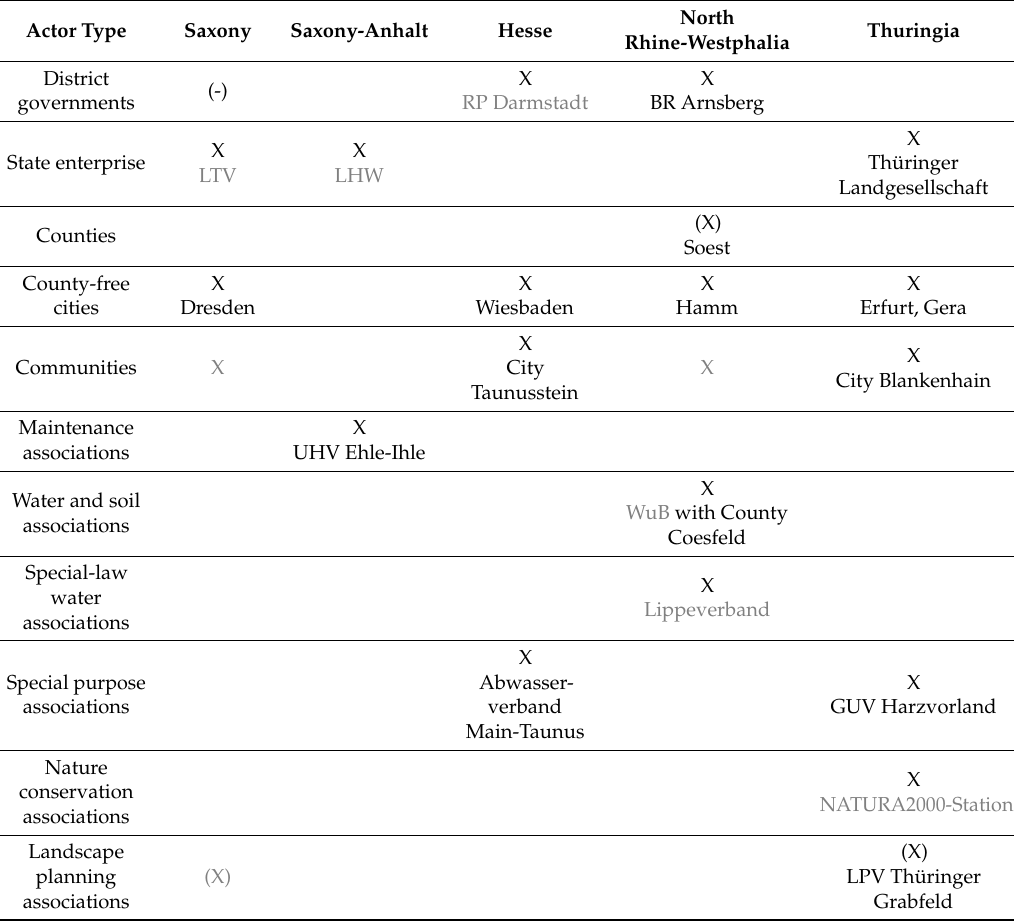
Table 1. Local policy addressees for realizing specific measures to reach Water Framework Directive (WFD) goals in each selected federal state and cases